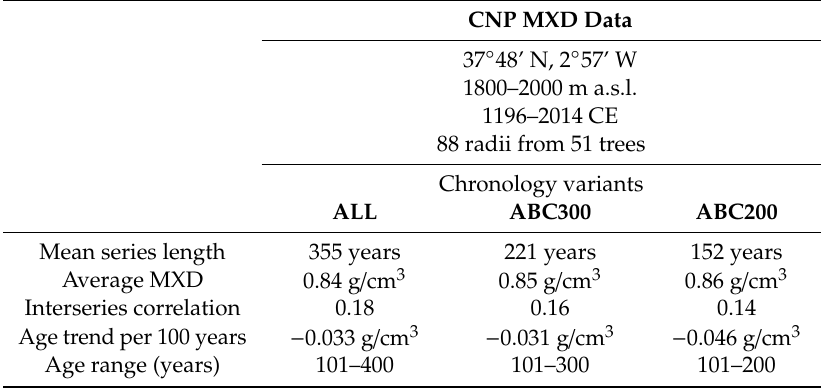
Table 1. Cazorla Natural Park maximum densities (MXD) data and chronology characteristics. The last line indicates the age range over which MXD age trends (second last line) were